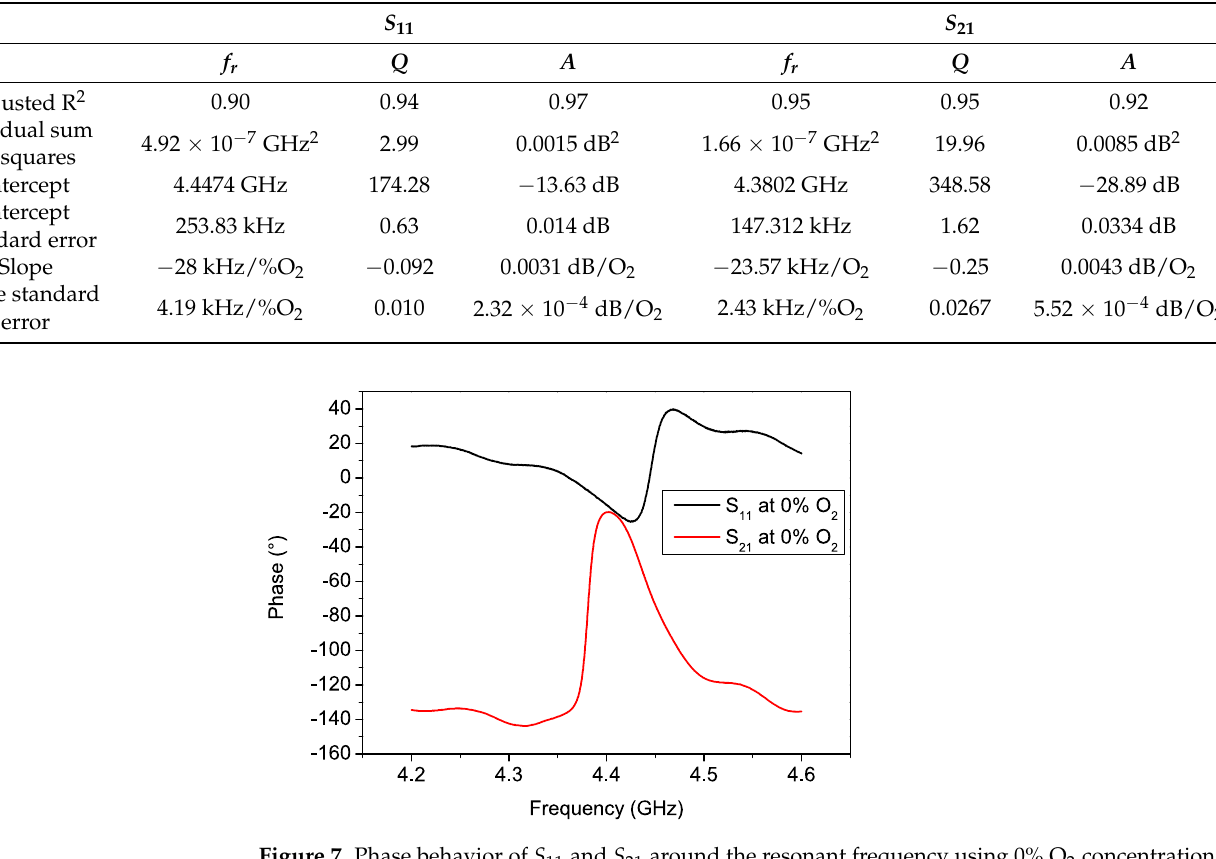
Figure 7. Phase behavior of S 11 and S 21 around the resonant frequency using 0% O 2 concentration as an